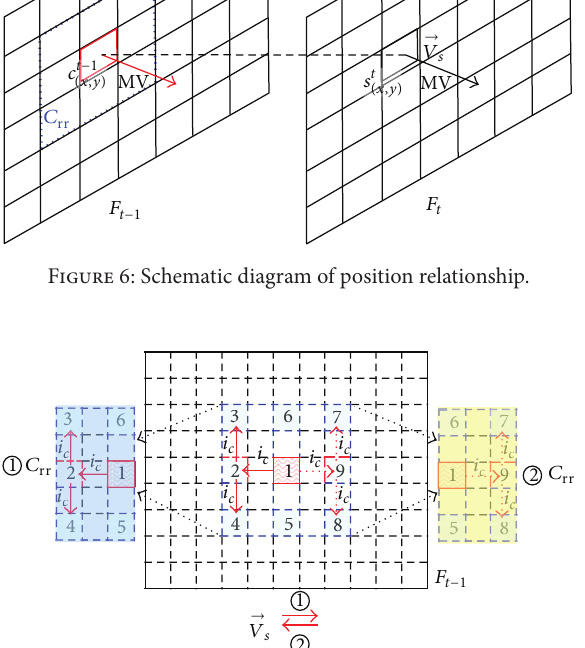
with horizontal rr